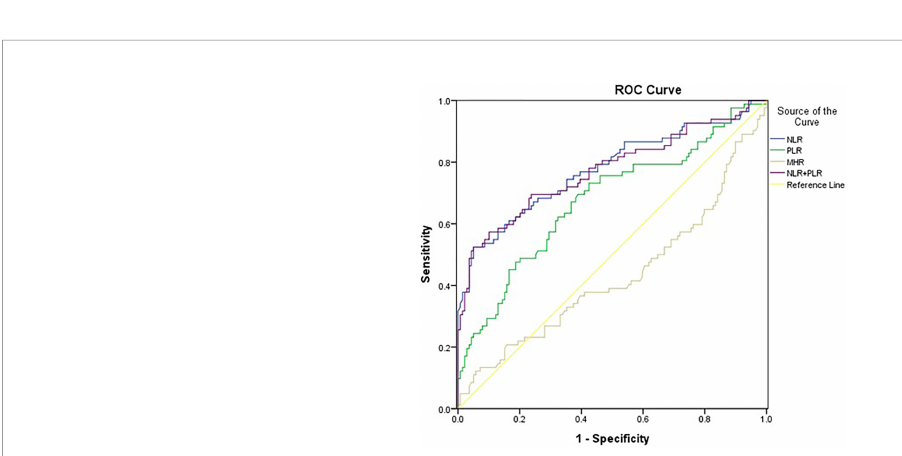
FIGURE 4 | Adjusted hazard ratios for mortality by NLR, PLR and MHR.